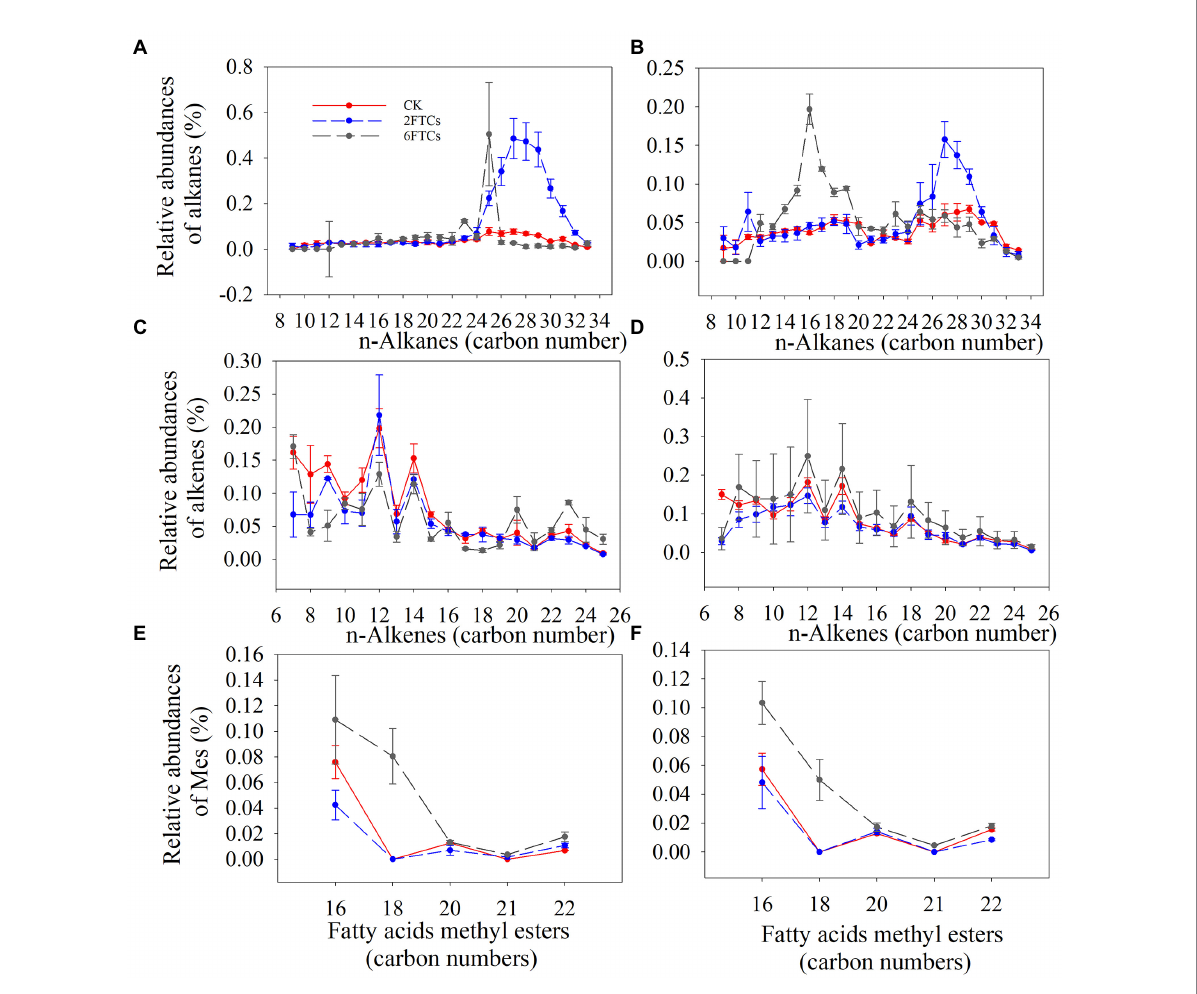
FIGURE 3 Distribution and relative abundance of Alkane in (A) 0–10 cm; (B) 50–60 cm. Alkene in (C) 0–10 cm; (D) 50–60 cm. Fatty acid methyl esters in (E) 0–10 cm; (F) 50–60 cm. CK, 2FTCs, and 6FTCs represent culture at 5 ° C, two freeze–thaw cycles, and six freeze–thaw cycles,